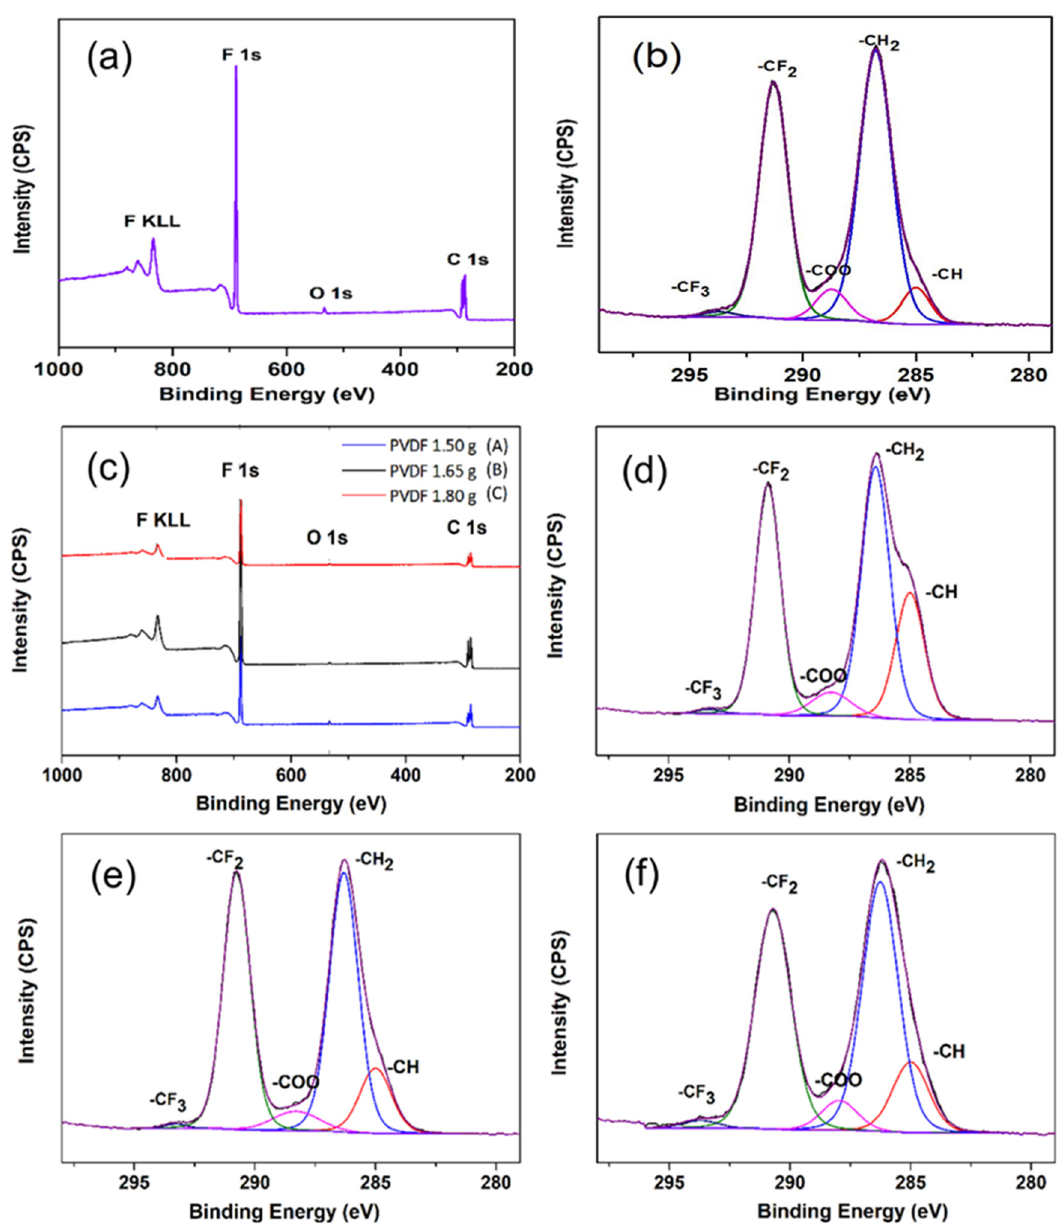
Figure 5. ( a , b ) XPS spectra of pure PVDF powder and ( c – f ) XPS spectra of electrospun PVDF nanofibers for samples A, B and C. Table 1. The elemental compositions (in atomic percentage) of the pristine PVDF powder and the as-prepared fiber samples.